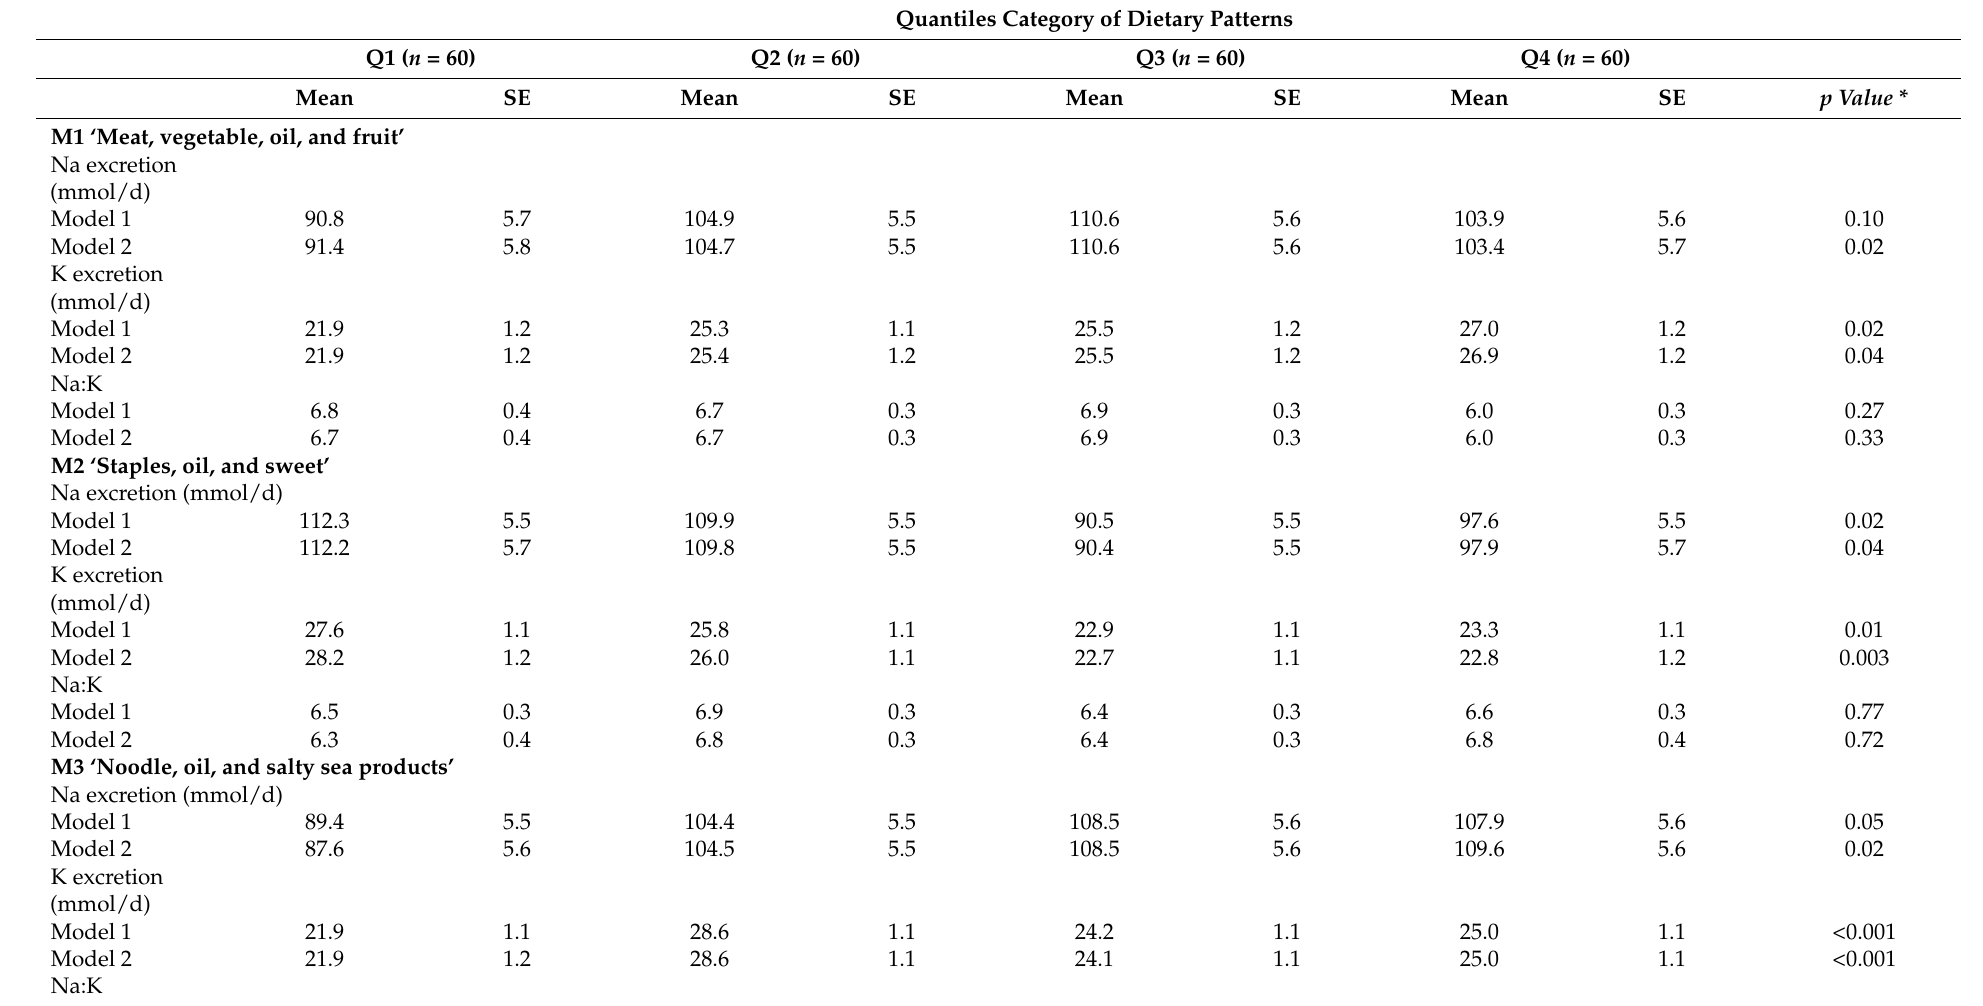
Table 3. Multivariate-adjusted means and SE for urinary sodium and potassium excretion and sodium:potassium ratio by quintile of each dietary pattern for 240 Indonesian